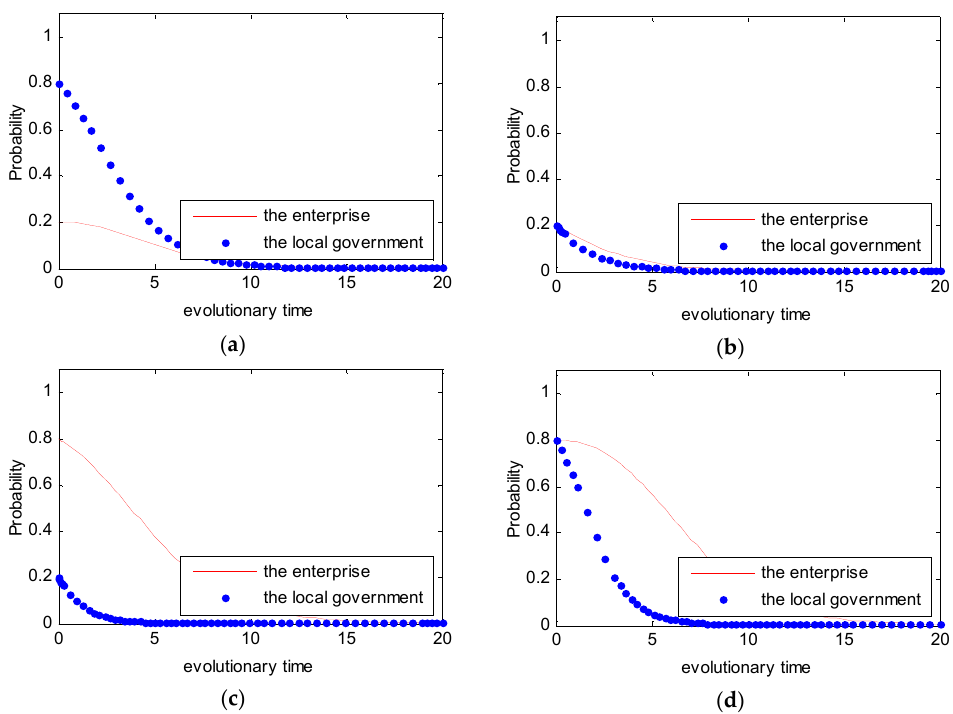
Figure 8. Probability of choosing a strong willingness strategy for di ff erent time t. ( a ) p t ( 0 ) = 0.2, q t ( 0 ) = 0.8; ( b ) p t ( 0 ) = 0.2, q t ( 0 ) = 0.2; ( c ) p t ( 0 ) = 0.8, q t ( 0 ) = 0.2; and ( d ) p t ( 0 ) = 0.8, q t ( 0 ) = 0.8.